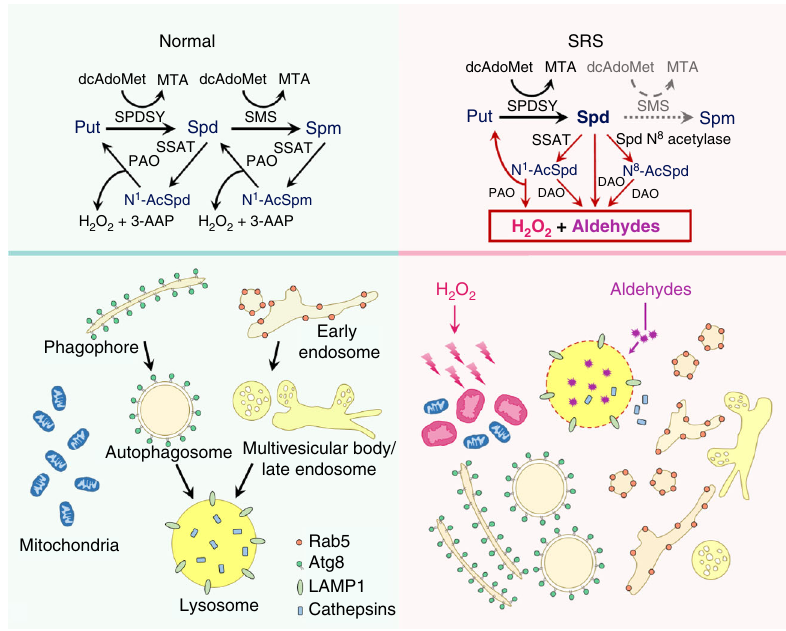
Fig. 8 Diagram of cellular responses to spermidine catabolism caused by SMS de fi ciency in SRS. SMS is an aminopropyltransferase for catalyzing spermidine into spermine. SMS de fi ciency leads to spermidine buildup, followed by the induction of acetylation and oxidation. The accumulated polyamine catabolism metabolites, H 2 O 2 and aldehydes, cause oxidative stress and lysosomal dysfunction, which further impair autophagy fl ux, endocytosis, and mitochondria